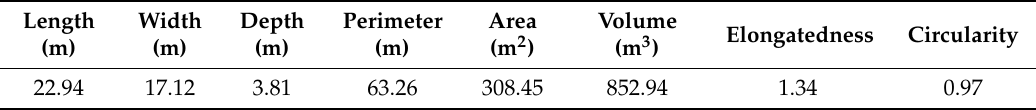
Figure 9. Geometric characteristics: ( a ) Aerial image and sinkhole boundaries; and ( b ) 3D profile view of selected sinkhole. Table 3. Results of sinkhole geometric